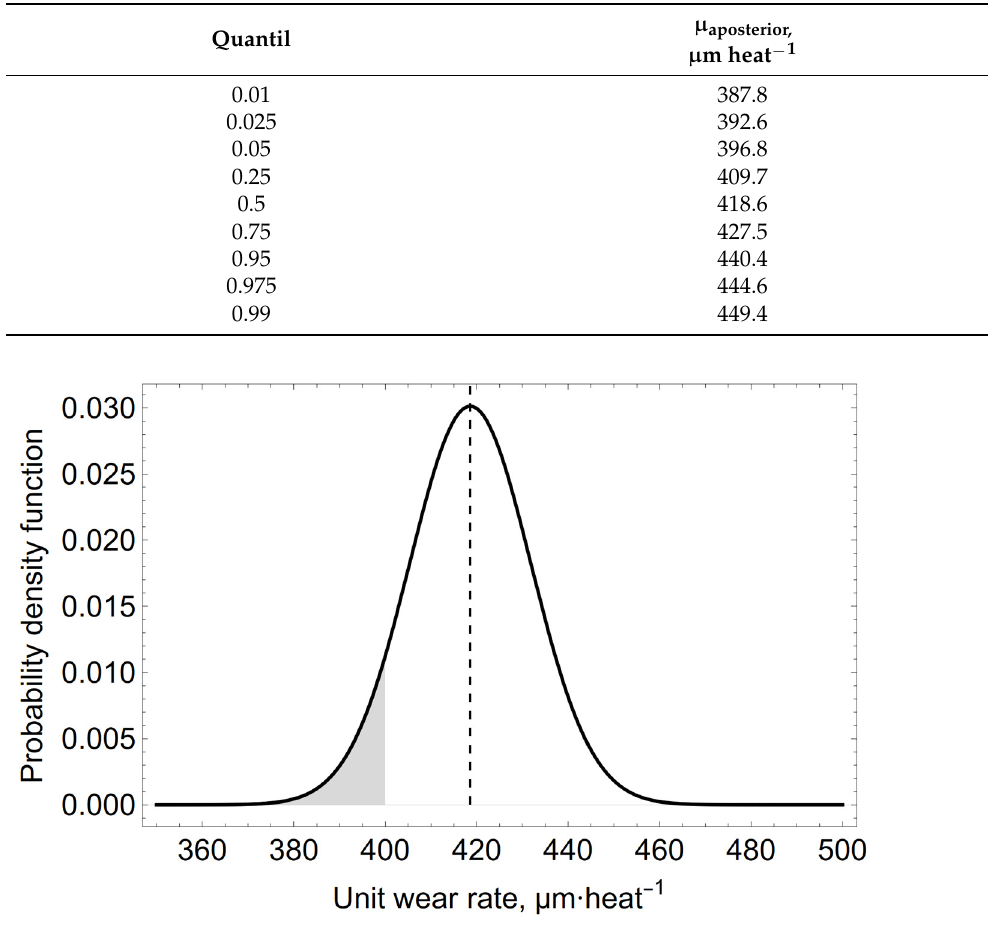
Figure 9. The shaded area shows an 8% probability that the value of the unit refractory wear rate in the oxygen converter slag spout zone will be below 400 µm heat − 1 . the oxygen converter slag spout zone will be below 400 µ m heat − 1